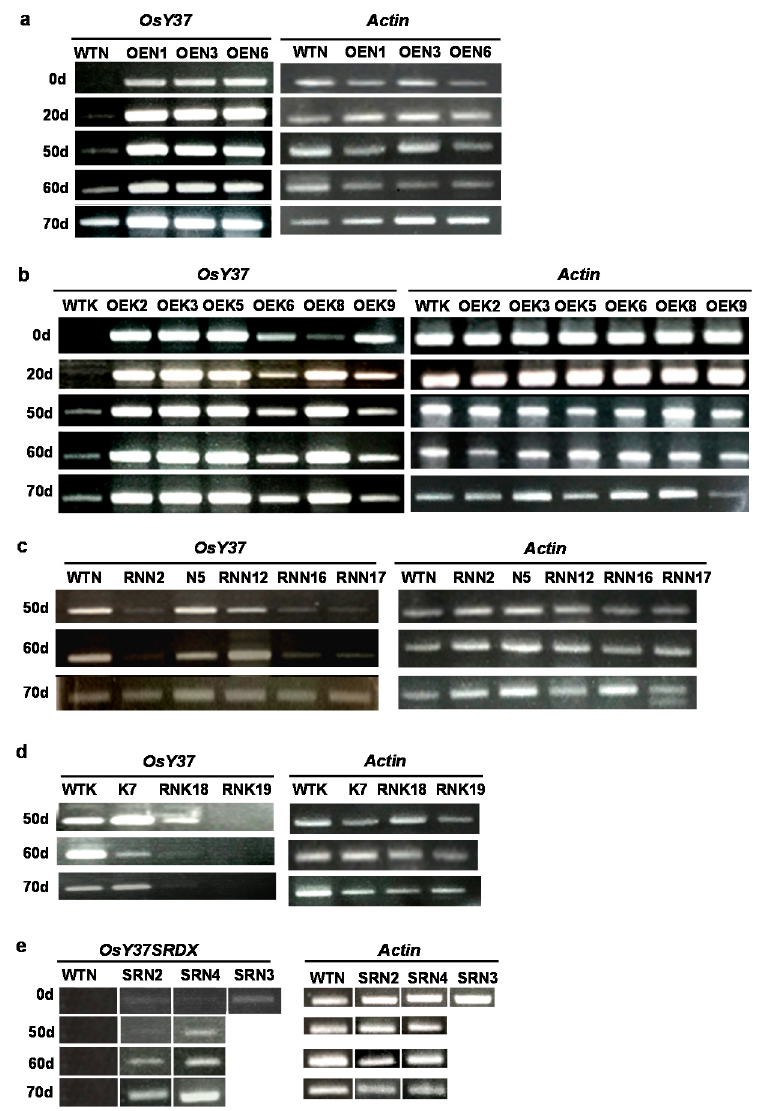
Figure 7. Transcriptional gene expression determined by reverse transcription polymerase chain reaction (RT-PCR) analysis. Total RNA was extracted from flag leaves at the indicated days after heading. Semi-quantititative RT-PCR was performed using OsY37 primers Osy2 and Osy752 which